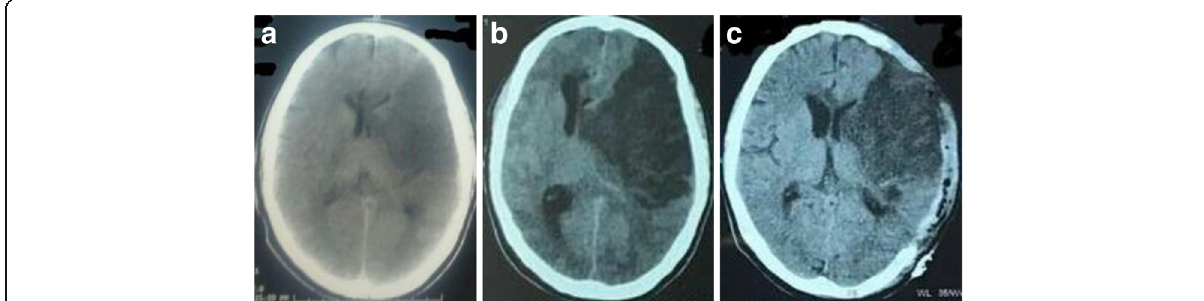
Fig. 3 a 49-year-old male presenting with left MCA infarct, GCS 13/15. b CT after deterioration, GCS 6/15, midline shift 10 mm. c Postoperative CT showing resolution of midline shift, patient was discharged GCS 15 and mRS